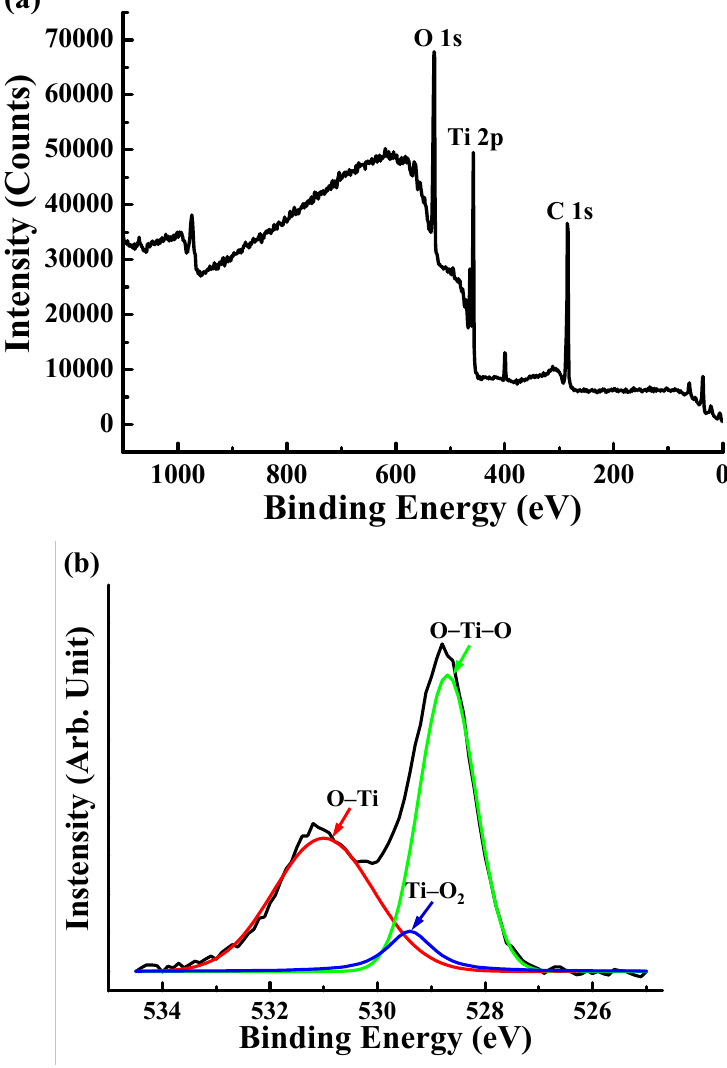
Figure 3. ( a ) The high-resolution XPS survey spectrum of the TiO sample and ( b ) the regional scans of O 1s peaks taken from the TiO sample